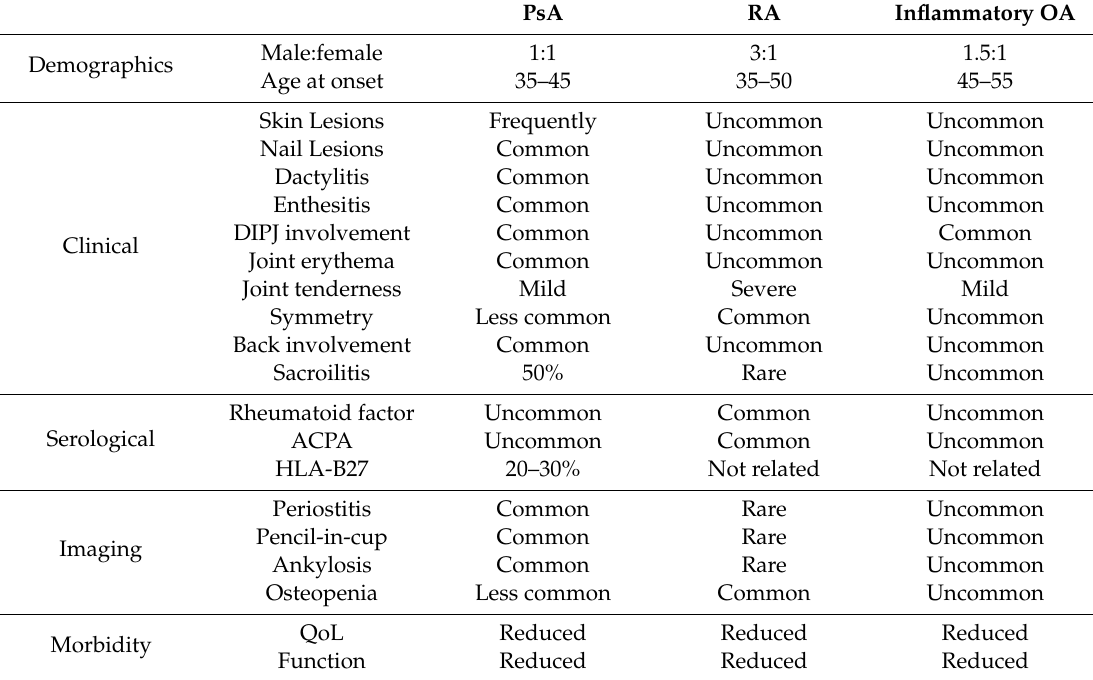
Table 2. Comparison of the clinical and biological phenotype of Psoriatic Arthritis (PsA) with that of rheumatoid arthritis (RA) and osteoarthritis